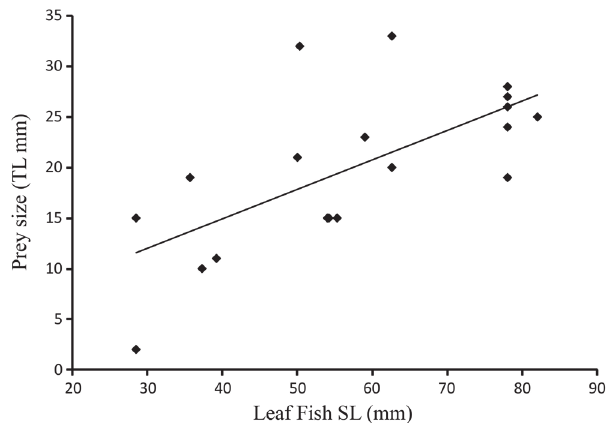
Fig. 3. Prey size (total length, in mm) in relation to predator’s size (standard length, in mm) for specimens of the leaf fish Monocirrhus polyacanthus (r 2 = 0.44, F = 13.24, p = 0.002, Number of measured preys =